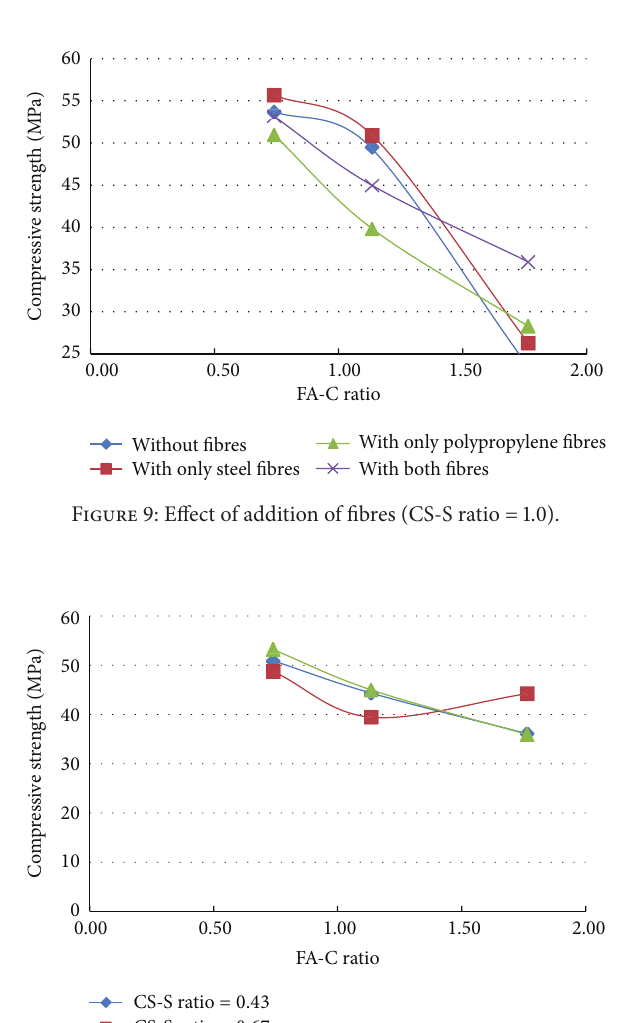
Figure 11: Compressive strength versus CS-S ratio (specimens S28– S36: with both